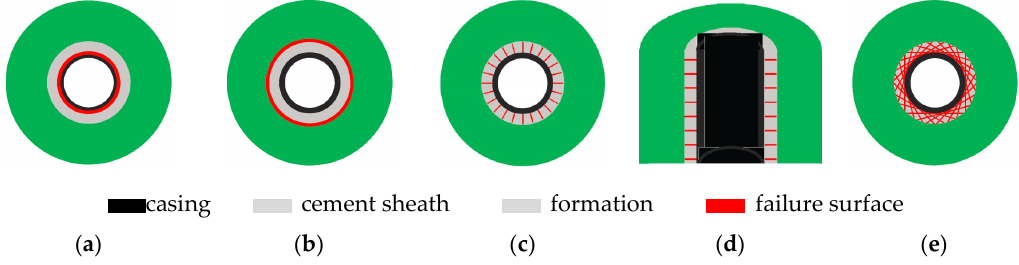
Figure 2. Failure modes in the cement sheath. ( a ) Inner de-bonding; ( b ) Outer de-bonding; ( c ) Radial cracking; ( d ) Disking; ( e ) Shear damage.